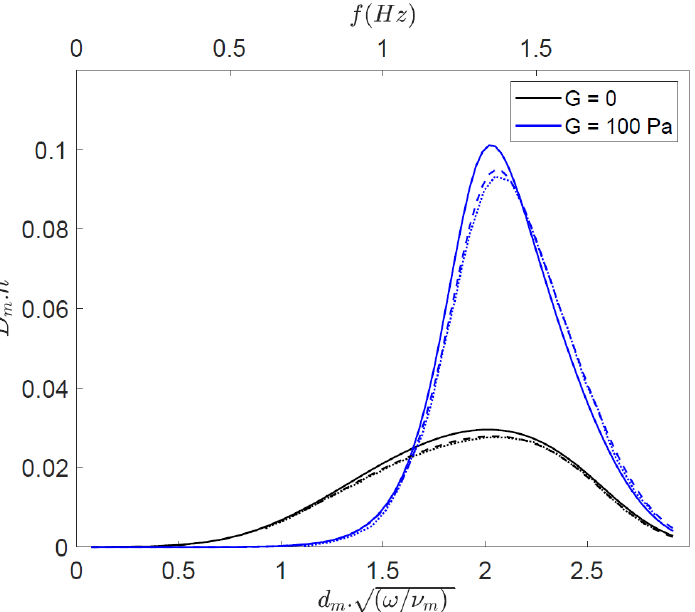
Figure 2. Surface wave damping rate as a function of frequency for different shear moduli of mud using formulation of LC (solid line), Macpherson [17] (dashed line) and Piedra-Cueva [28] (dot line), ζ = 100, h = 0.3 m, d m = 0.09 m, and ρ m = 1370 kg/m 3